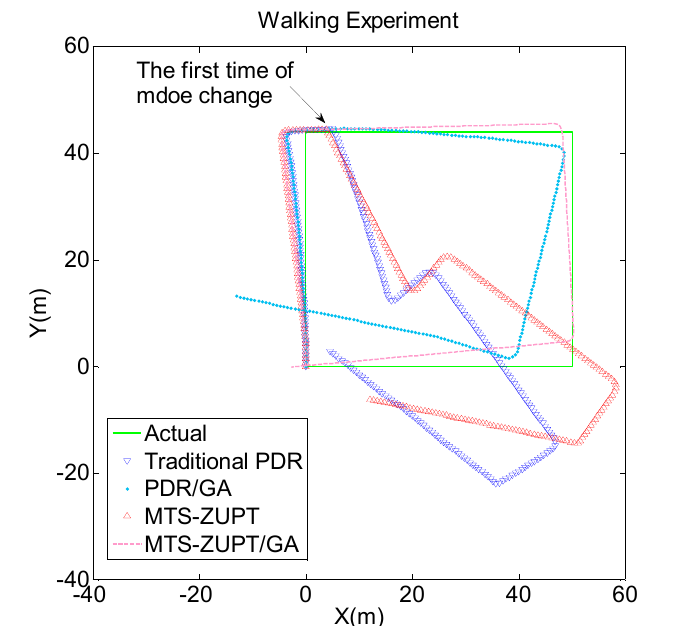
Figure 10. Judgment of Smartphone Using-mode.